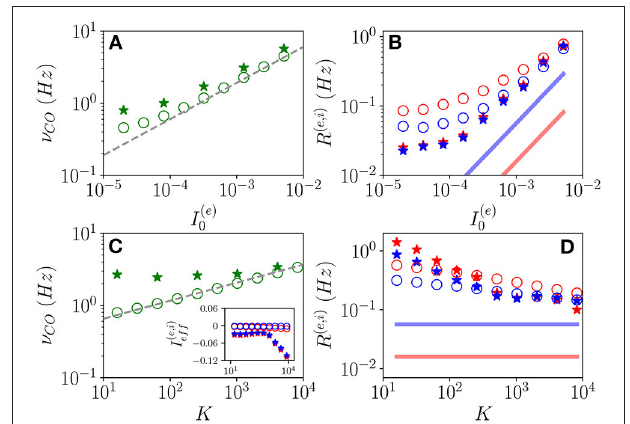
FIGURE 11 | Frequencies and amplitudes of O P oscillations. COs’ frequency ν CO vs. I ( e ) 0 (A) and K (C) and mean firing rates vs. I ( e ) 0 (B) and K (D) for the excitatory (red) and inhibitory (blue) populations. The dashed line in (A,C) K 1 / 4 ) for the frequencies. In I ( e ) 0 1 / 2 ( corresponds to a power law-scaling ∝ ∝ the inset in (c), the effective mean input currents I ( e ) eff ( I ( i ) eff ) of the excitatory (inhibitory) population are shown vs. K . The solid red (blue) line in (B,D) denotes the asymptotic MF result R ( e ) ( R ( i ) ). The data obtained from network (MF) simulations are denoted as stars (circles). The data reported in (A–D) refer to the open circles in Figures 1A,B , respectively. For network simulations, we employed N ( e ) 80,000 and N ( i ) = =